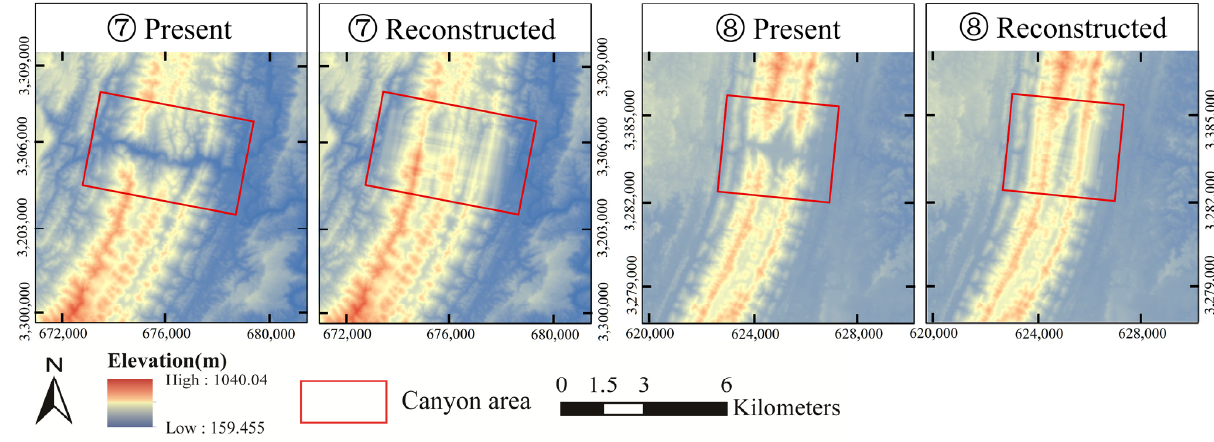
Figure 15. The paleotopographic DEM of each transverse canyon in the study region. Figure 16 depicts the paleotopography of the study region following the reconstruction of all transverse canyons. The outcome reproduces the ancient pattern of the eastern Sichuan fold belt, which gives essential information for inferring the paleodrainage pattern. Table 1 displays the values of each transverse canyon’s spatial properties. The aspect ratios of transverse canyons in the study region vary from 0.14 to 0.21, and the difference between canyons (cid:192) , (cid:193) , (cid:194) , (cid:195) , (cid:197) , and (cid:198) is less than 0.03. The statistics may suggest that the impact of river erosion on the region’s mountains is relatively uniform.